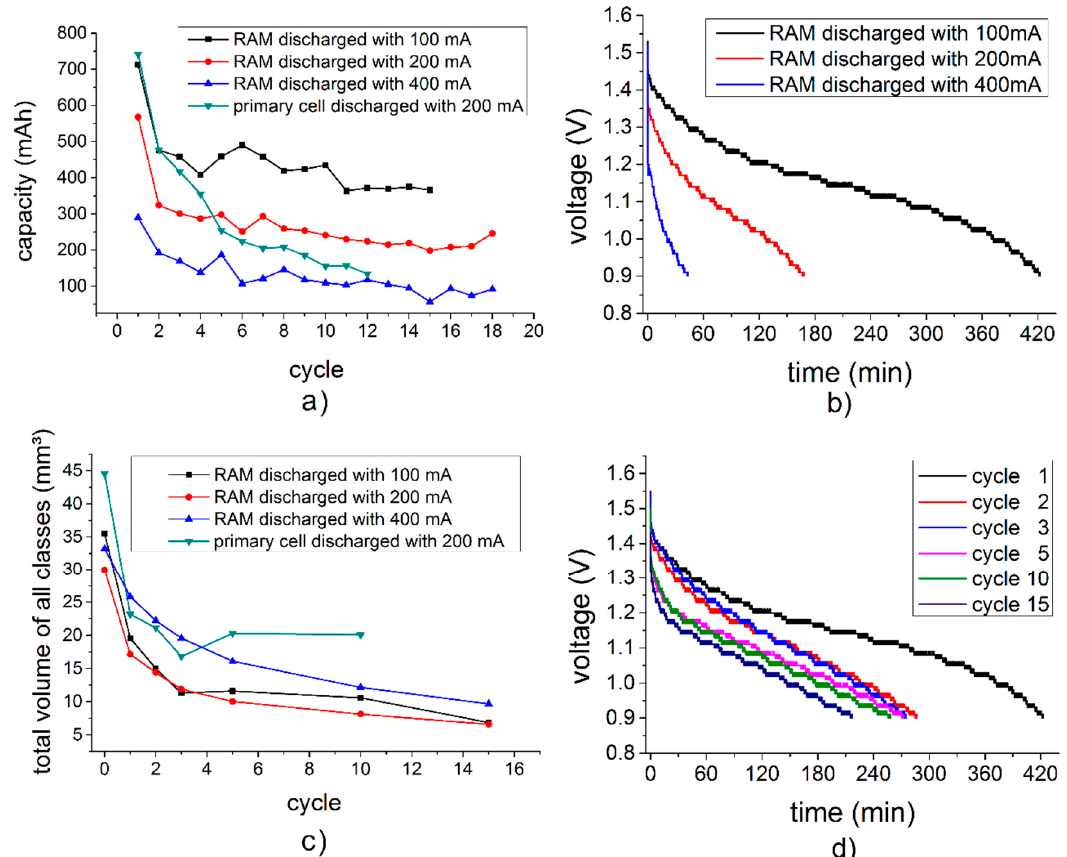
Figure 2. ( a ) Battery capacities remaining after a given number of discharge cycles, ( b ) discharge curves of pristine rechargeable alkaline-manganese (RAM) batteries at different discharge currents, ( c ) total volume of all segmented zinc particles and ( d ) discharge curves of a RAM battery (100 mA) during different cycles.